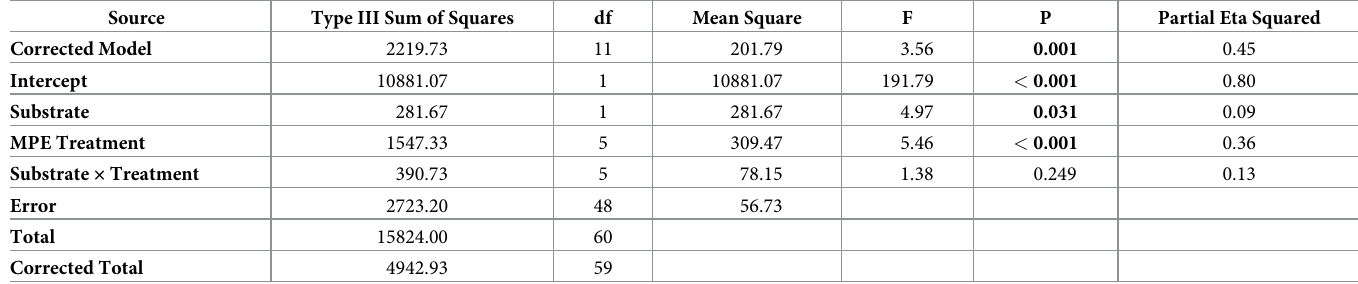
Table 1. Two-way ANOVA of the mean number of oysters consumed within the MPE experiment (bold P � 0.05). The corrected model term excludes variability explained by the intercept, thereby constituting an overall test of the dependent variables. Source